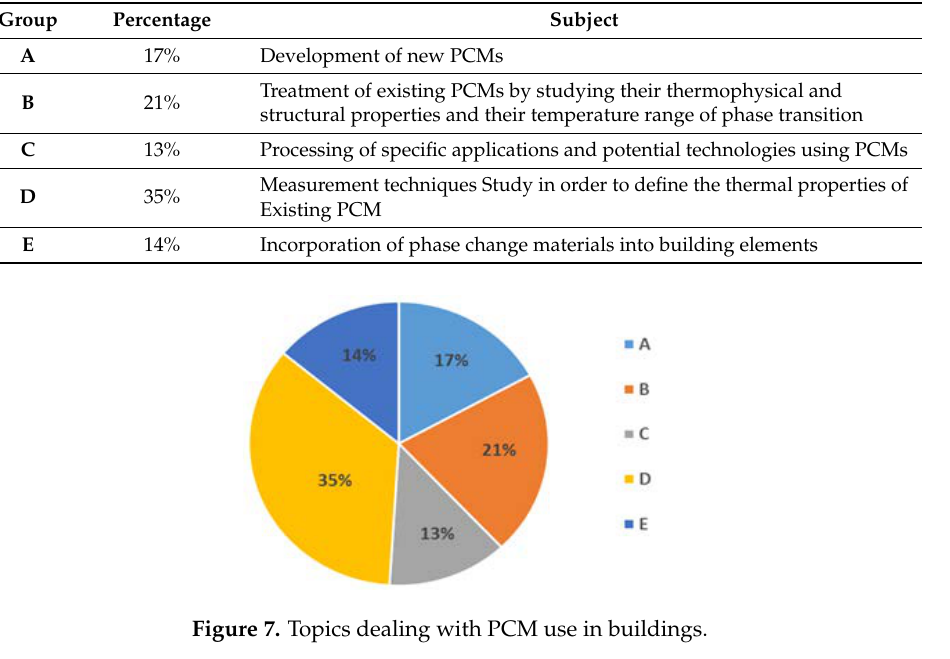
Figure 6. Distribution of families of materials inventoried in the studied literature through their usage.